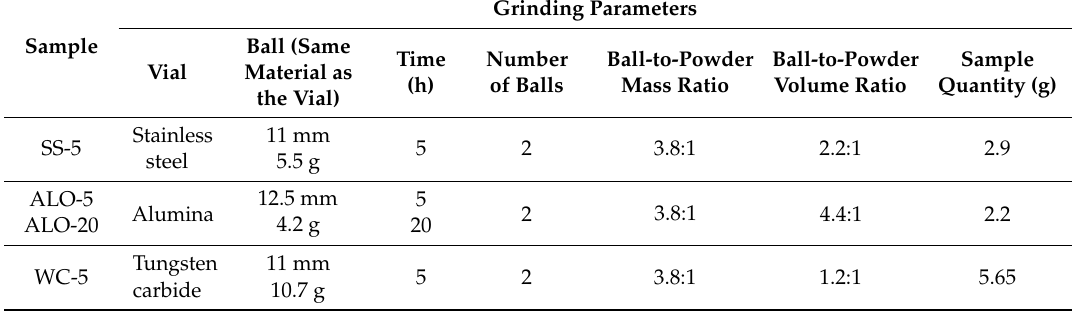
Table 1. Grinding parameters used for high-energy